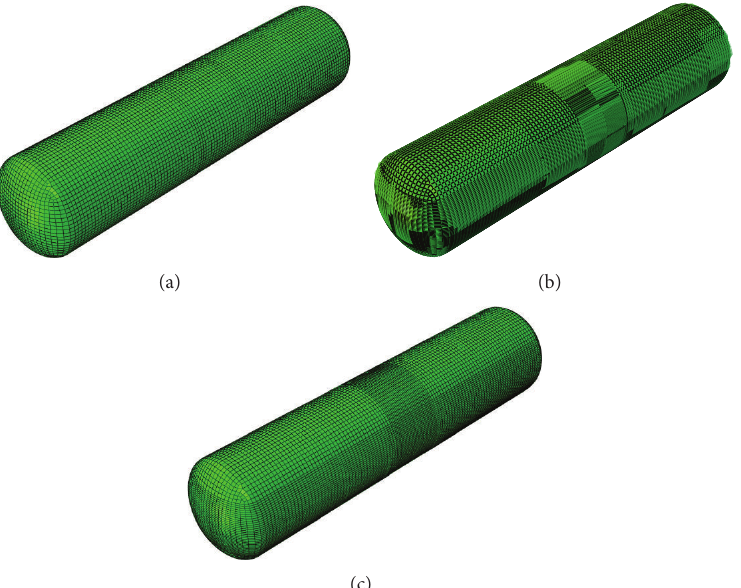
Figure 6: Different mesh discretizations of the tank car: (a) coarse mesh, (b) medium mesh, and (c) fine mesh. The meshes are made of solid C3D8R elements. There are four C3D8R elements in the thickness of the tank to develop a bending resistance. The size of the elements in the impact zone is 75mm, 50mm, and 35 mm for the coarse, medium and fine meshes,